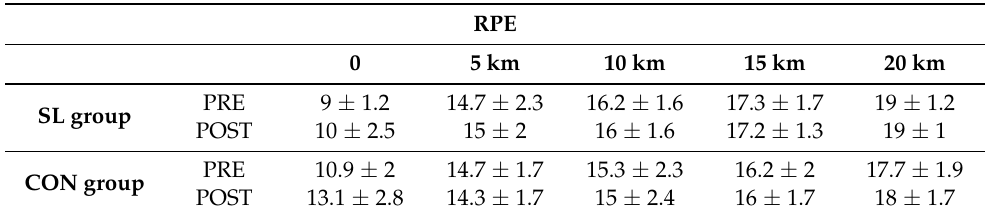
Table 2. Rating perception of effort (RPE) during the 20 km cycling time-trial every 5 km for SL and CON groups in PRE and POST